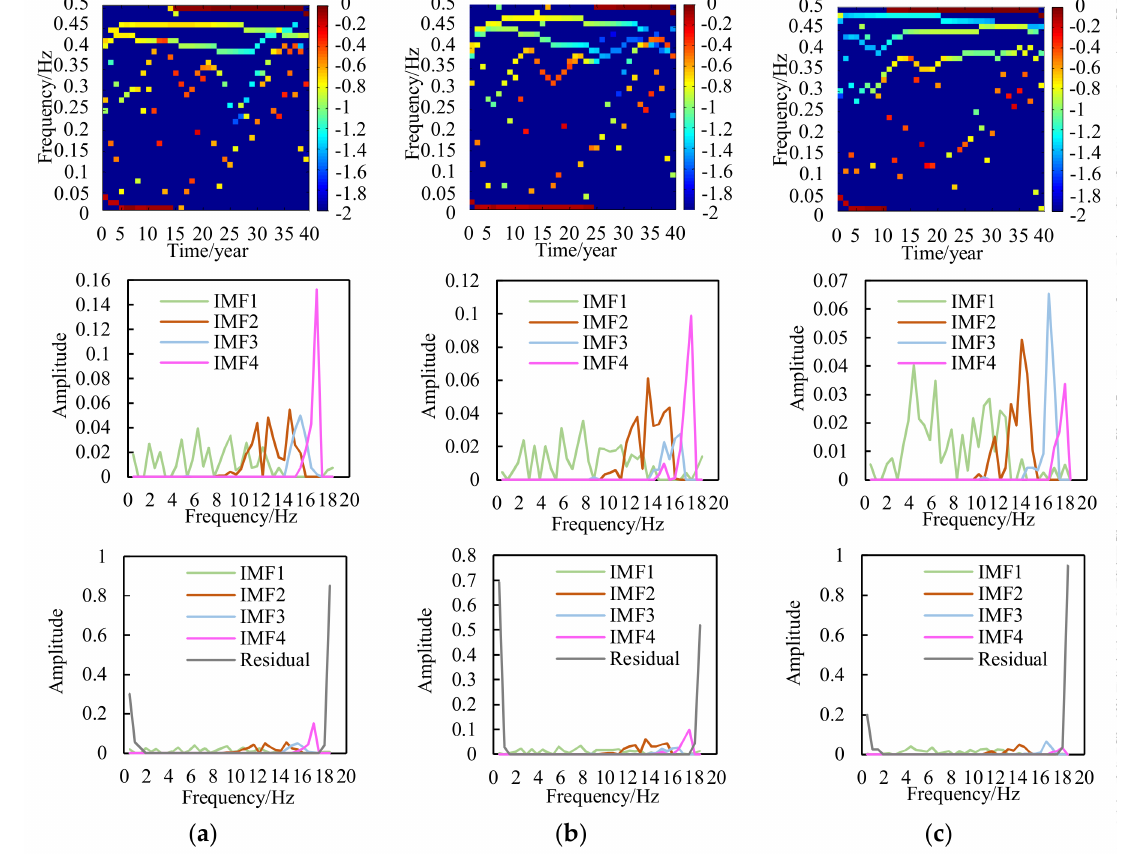
Figure 4. Hilbert spectrums and marginal spectrums of runoff components obtained based on ( a ) SD criteria; ( b ) GR criteria; and ( c ) MTED at the Suide